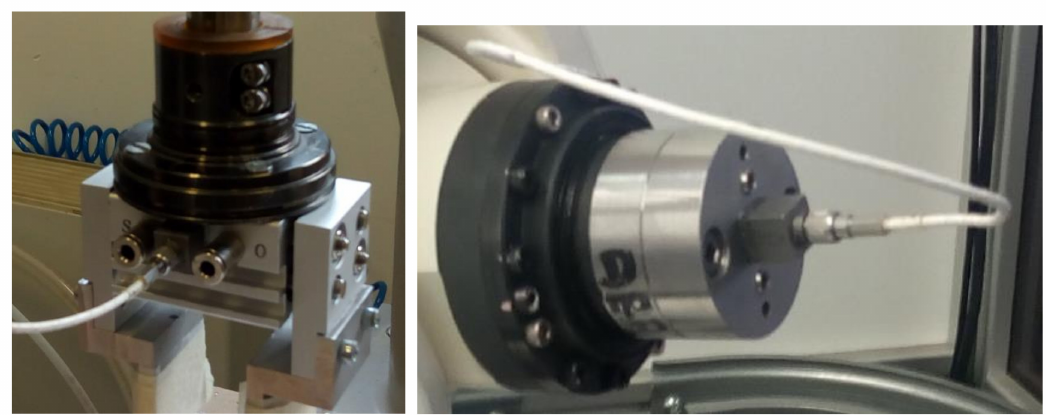
Figure 8. The end e ff ectors of the robots equipped with accelerometers.